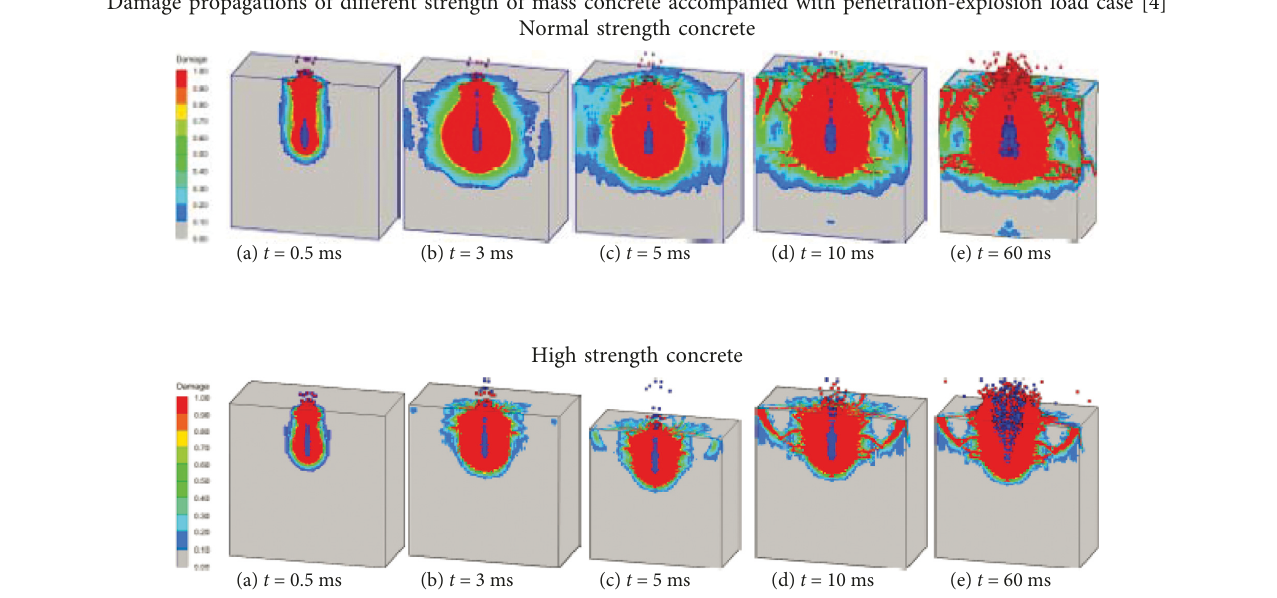
Table 11: Summary on FEA numerical simulation failure modes for mass concrete under combined explosion and penetrations projectile